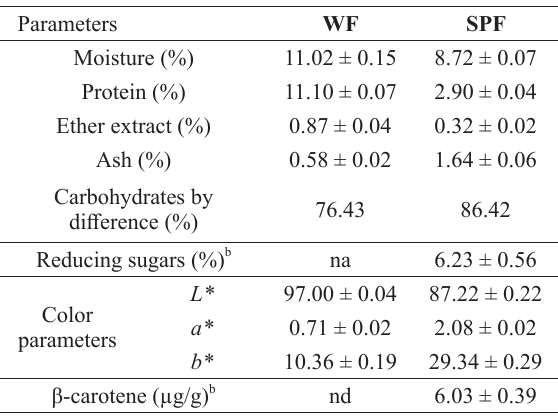
a Mean ± standard deviation; WF = refined wheat flour; SPF = yellow sweet potato flour; na = not analyzed; nd = below the limit of detection. b The values are in dry